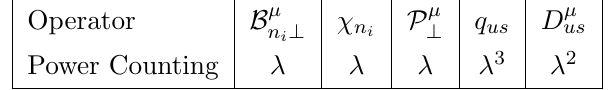
Table 1. Power counting for building block operators in SCET I